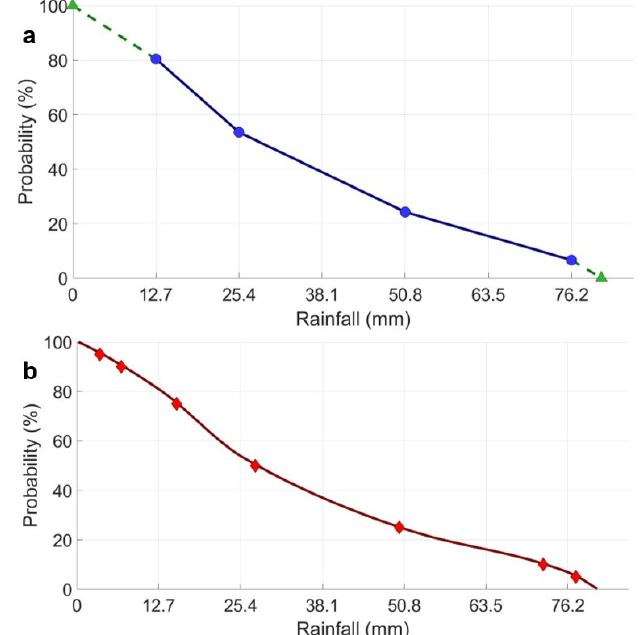
Figure 2. Example of the data interpolation technique used to transform the Probabilistic Quantitative Precipitation Forecast (PQPF) values from the ensembles into rainfall amounts for various probabilities of exceedance, with ( a ) showing the PQPF values from the High-Resolution Rapid Refresh Ensemble (HRRRE, blue circles) with the additional boundary values (green triangles) from zero rainfall and the absolute highest member rainfall amount inside the research domain, and ( b ) showing rainfall amounts associated with the probability of exceedance values (red diamonds) used in the study, after running the Piecewise Cubic Hermite Interpolating Polynomial (PCHIP) interpolation program.